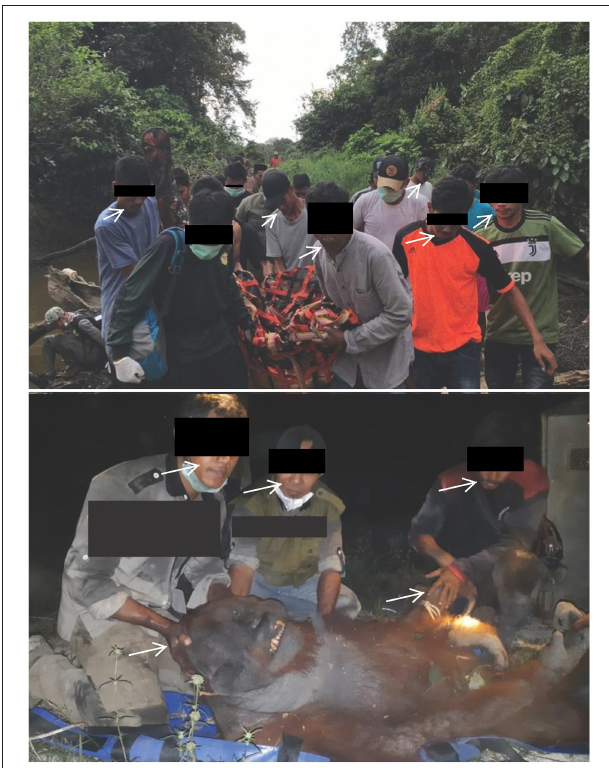
FIGURE 3 | PPE use and human proximity in wild-to-wild orangutan translocations prior to COVID-19 pandemic. Pictures showing examples of mixed use of PPE and human proximity to orangutans during capture and releases of wild orangutans prior to March 15, 2020. The orangutan in the top photo is in the orange and black net. Identifiable human features and organizational logos are obscured to protect anonymity. Image credits from top to bottom: BKSDA Aceh via KSDAE Top News blog http://ksdae.menlhk. go.id/assets/news/Translokasi_ortu1.jpeg ( 78); BKSDA Kalimantan Tengah via KSDAE Top News blog http://ksdae.menlhk.go.id/assets/news/gambb.jpg ( 80).